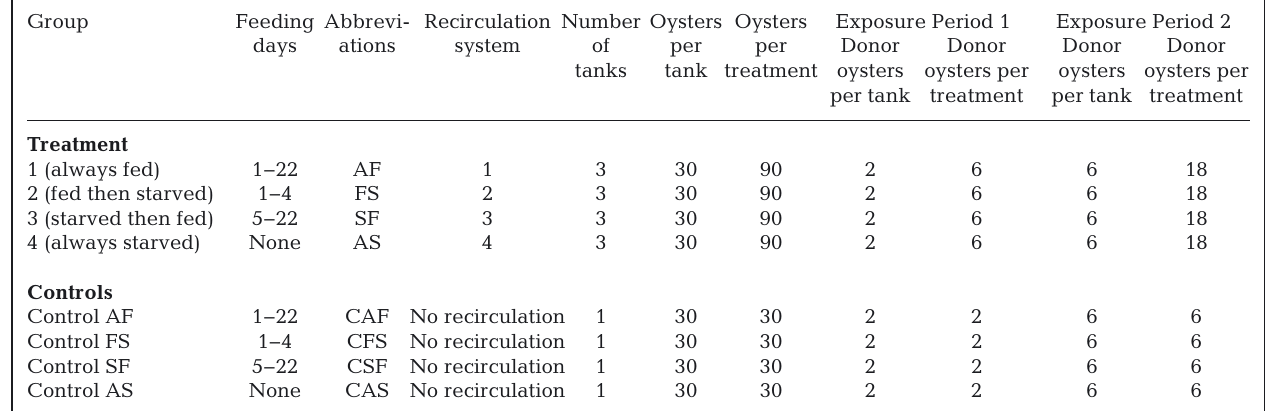
Table 2. Design of Expt 2 to assess feeding versus not feeding on 2 discontinuous periods of OsHV-1 exposure. Oysters were exposed to OsHV-1 infected donor oysters on Days 1−4 (Exposure Period 1: n = 6 donors per treatment) and Days 9−12 (Exposure Period 2: n